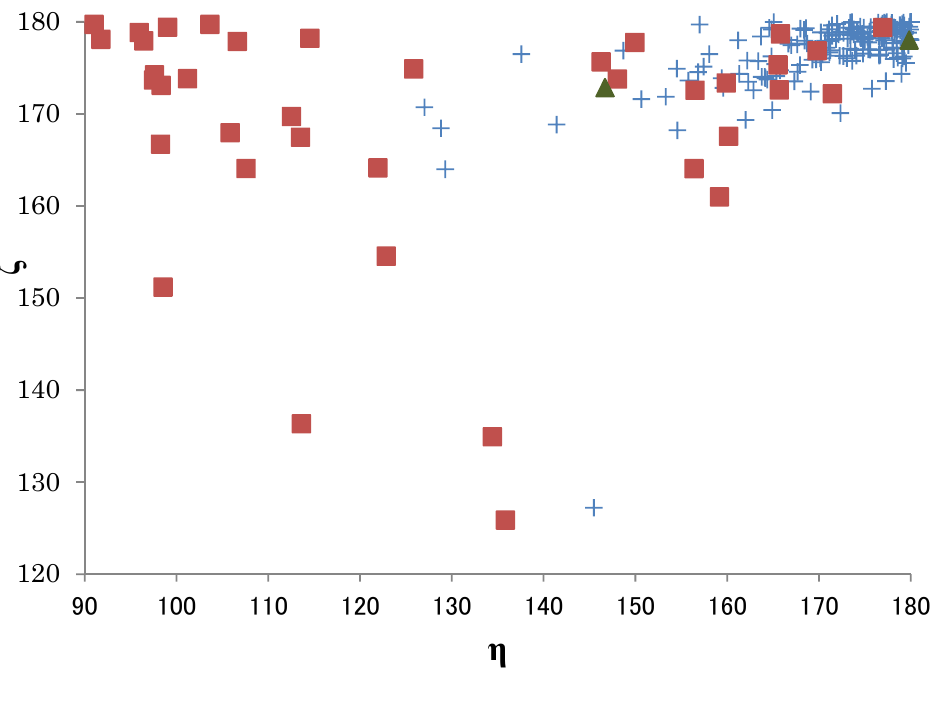
Figure 3. The absolute values of torsion angles of betaine structures reported in CSD (+), in PDB ( ■ ) and here ( ▲ ). The almost ζ values are seen between 160° and 180°, both in CSD and PDB, while the tendency of the distribution of the η values are different. The η values observed in CSD structures are almost over 150°, especially gathered near